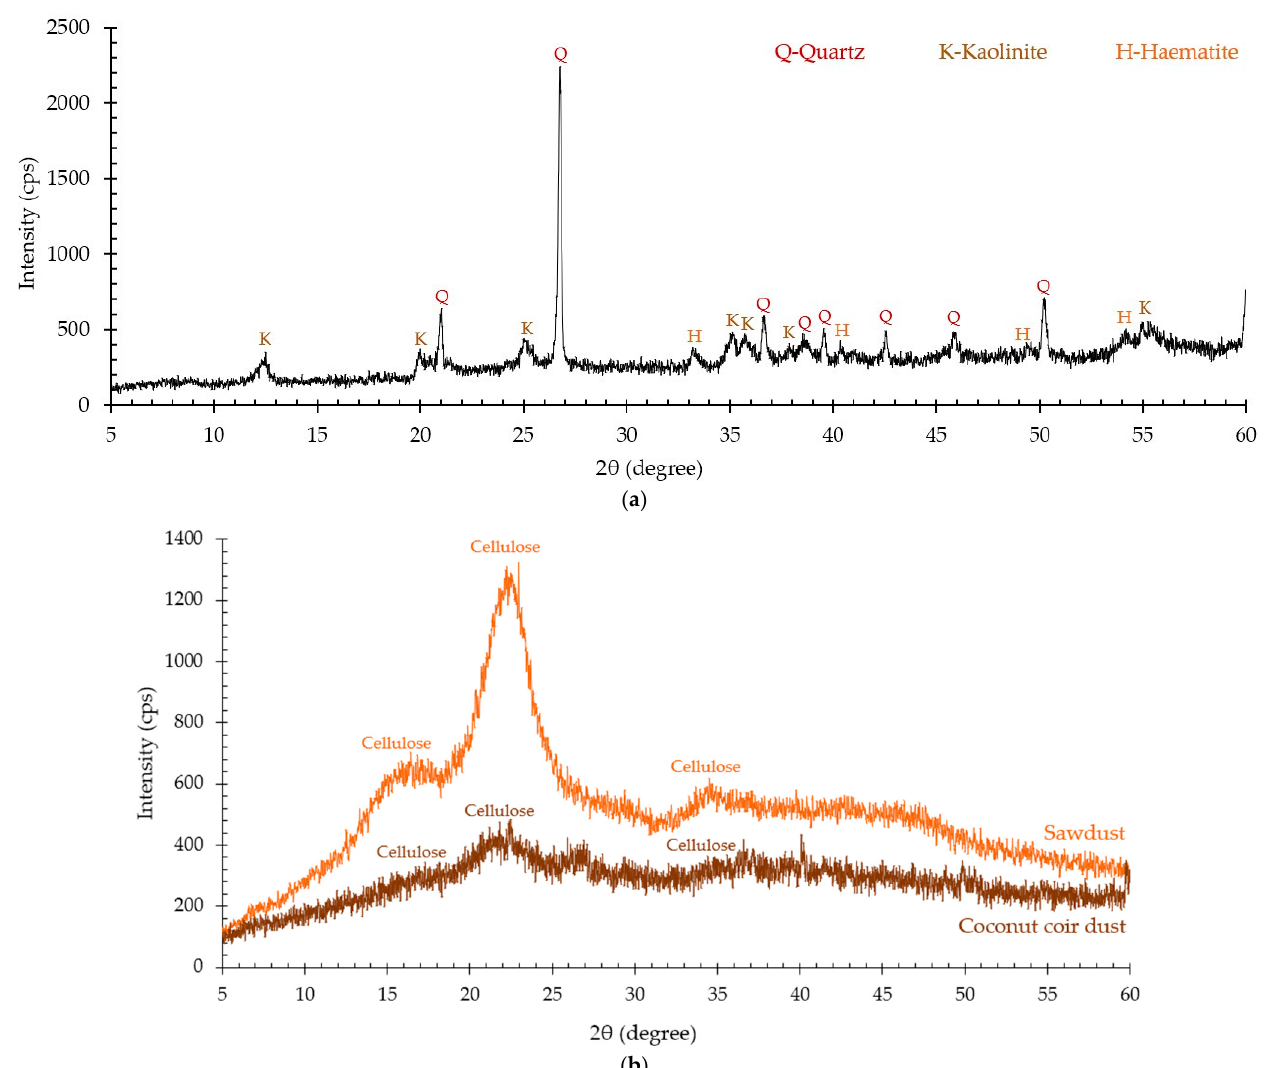
Figure 4. XRD spectra of raw materials: ( a ) red clay; ( b ) sawdust and coconut coir dust. Table 1. Thermophysical properties of raw materials.